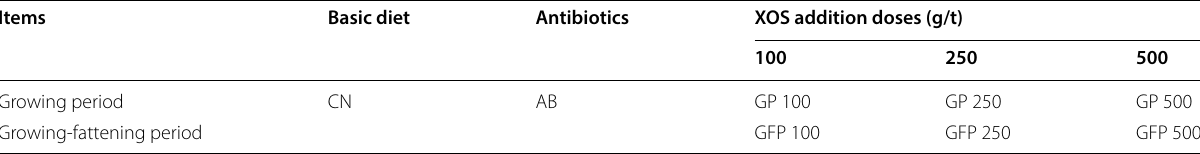
Table 1 Experimental animal groups according to different doses of XOS in animals at different growth stages